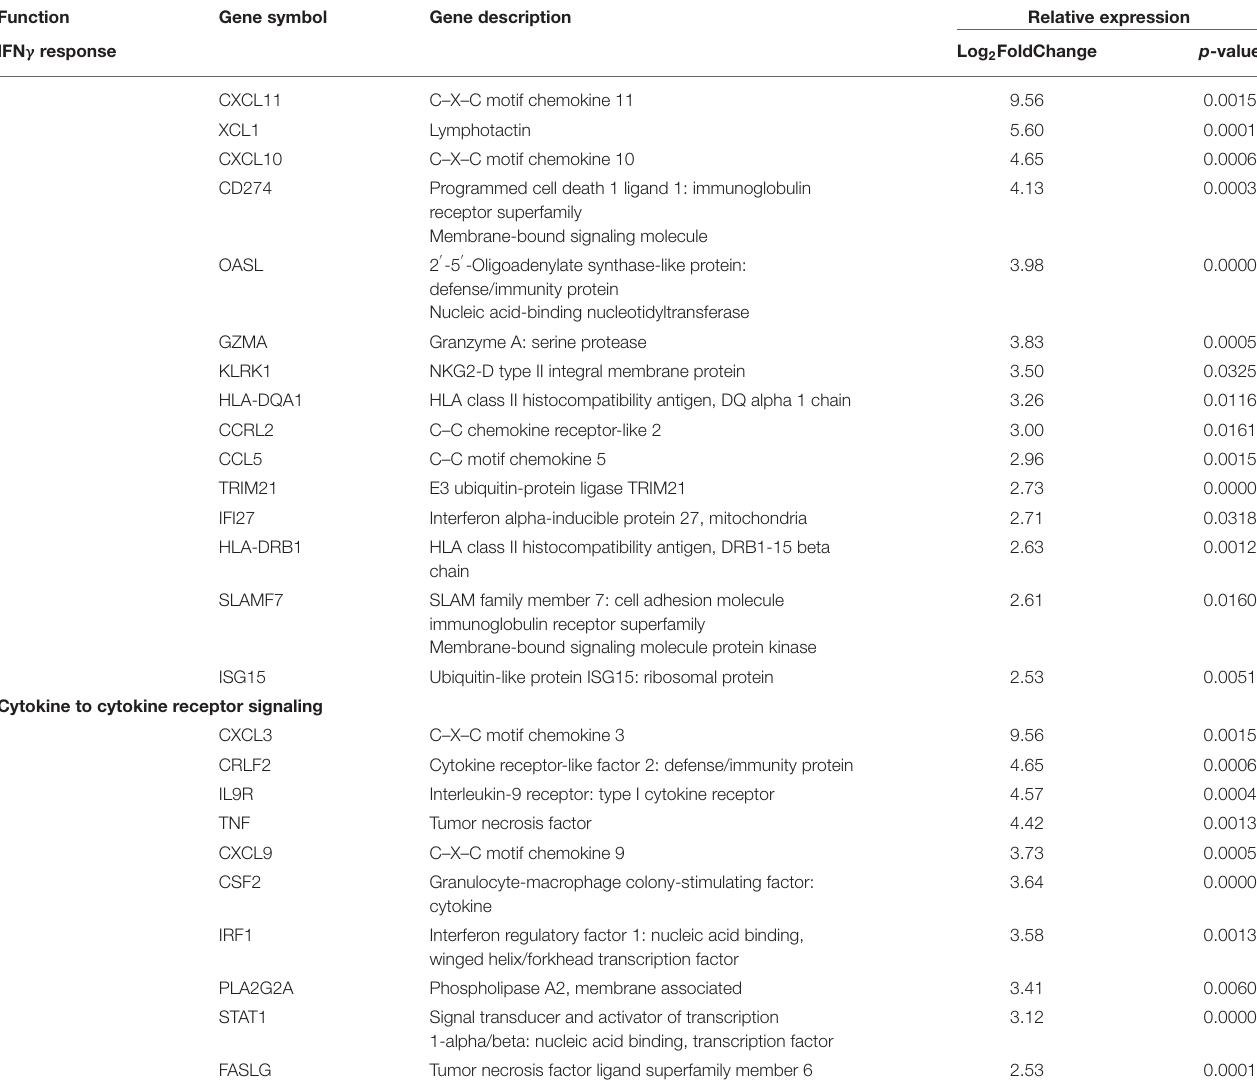
TABLE 4 | Pediatric active localized scleroderma (LS) vs. healthy control sample comparison identifies gene enrichment groups of interest relating to inflammatory signatures that was used to develop the Inflammatory Response Gene Signature in LS.